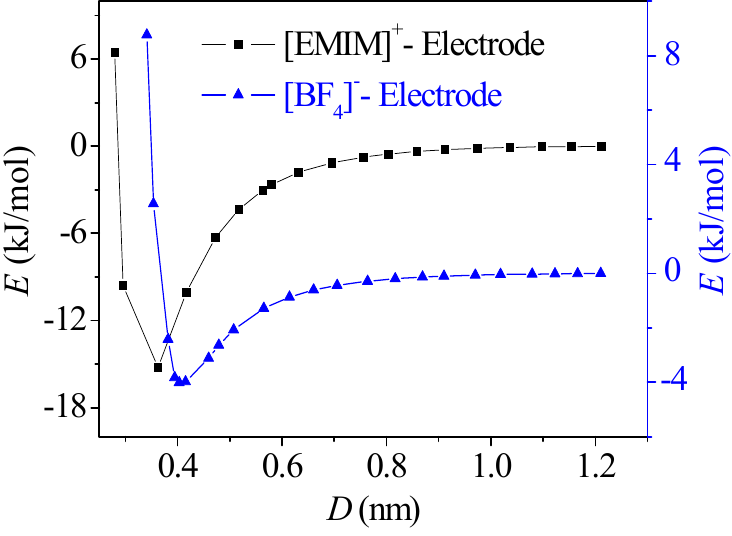
Figure 7. Total interaction energies of the [EMIM] + ion and [BF 4 ] − ion at different positions on the neutral electrode surface.